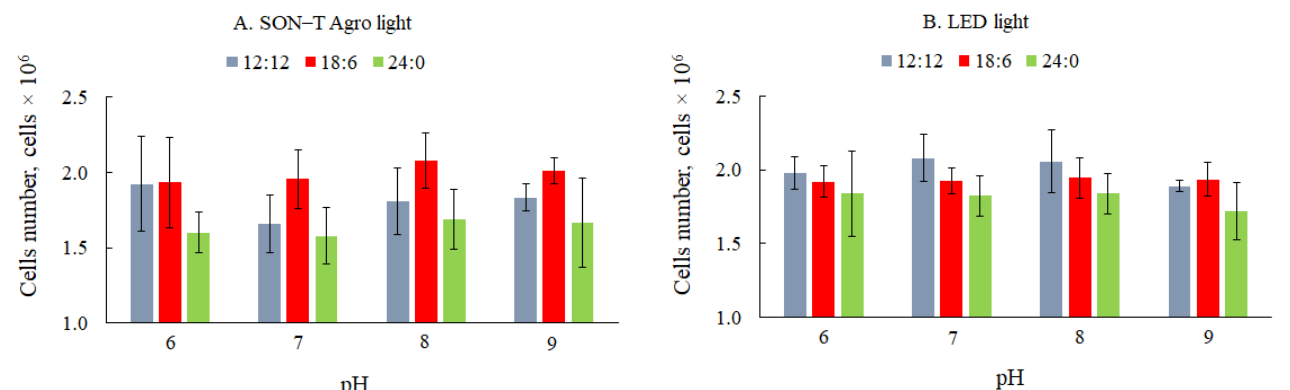
Figure 9. The average number of algae cells in culture in SON-T Agro light ( A ) and LED light ( B ) during different light:dark cycle.